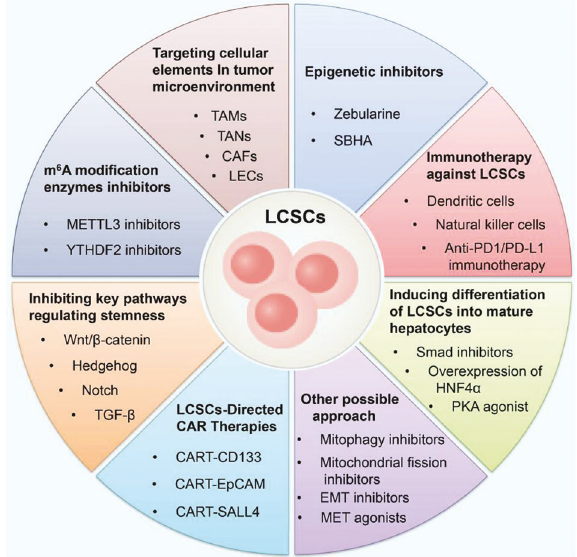
Fig. 8 Various therapeutic approaches that may eradicate LCSCs. LCSCs liver cancer stem cells, EMT epithelial – mesenchymal transition, MET mesenchymal-to-epithelial transition, TAMs tumor-associated macrophages, TANs tumor-associated neutrophils, CAFs cancer- associated fi broblasts, LECs lymphatic endothelial cells, SBHA suberoyl bis-hydroxamic acid, CAR-T chimeric antigen receptor T-cell